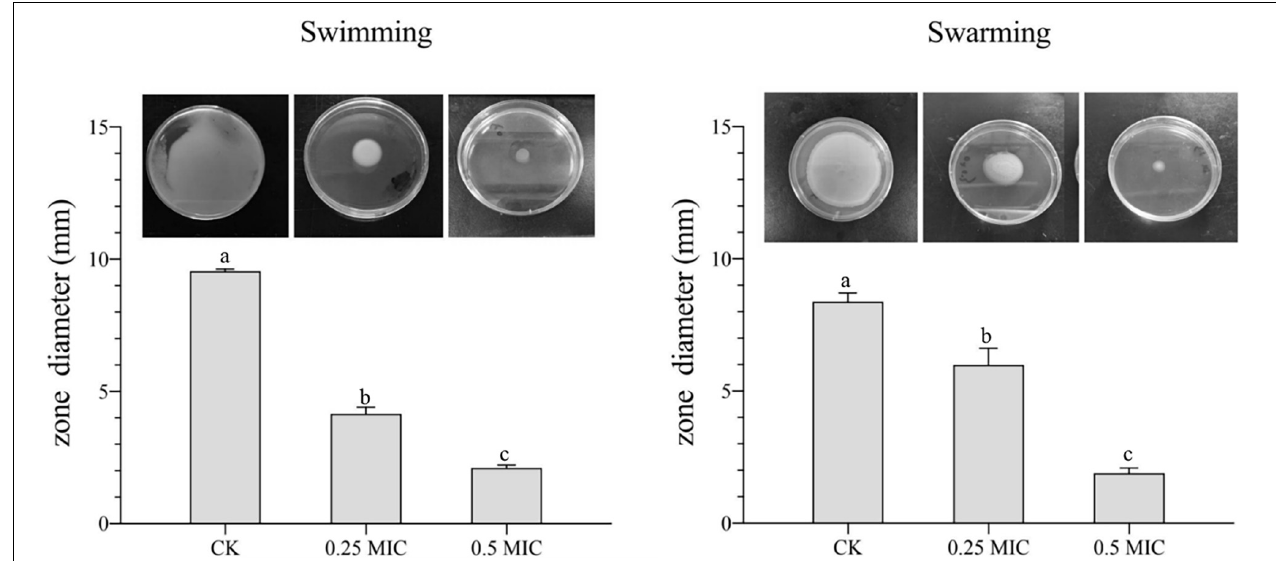
FIGURE 6 | Effects of Melissa officinalis L. essential oil on the motility of V. parahaemolyticus. CK is the V. parahaemolyticus without Melissa officinalis L. essential oil